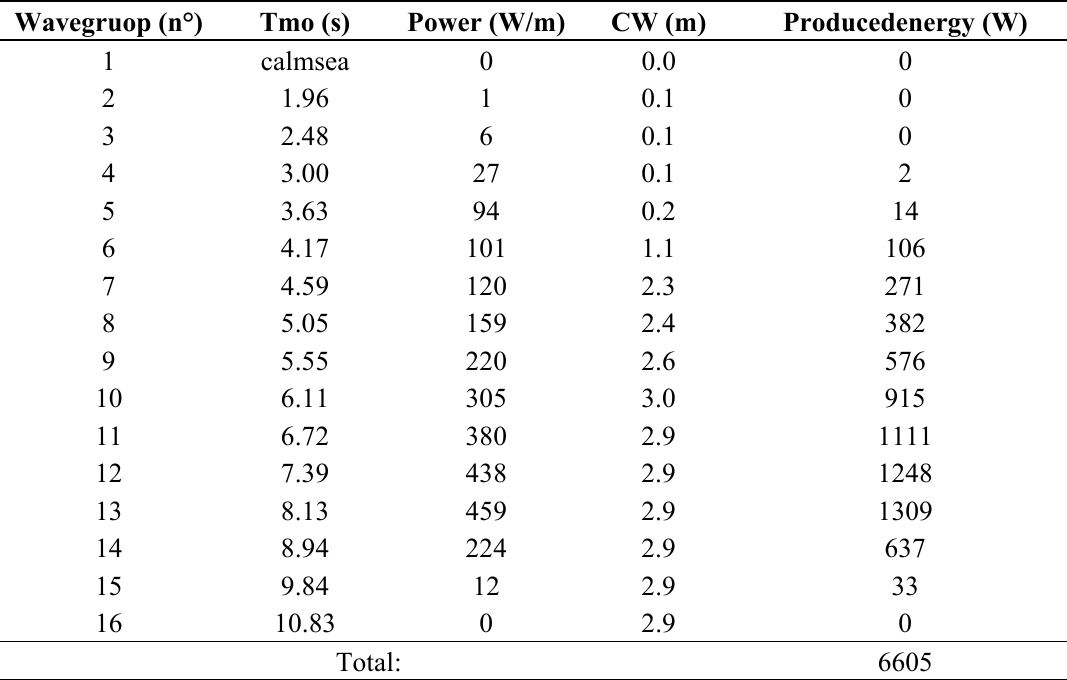
Table 1. Energy produced by a 6 m wide Seabreath, subject to a mild wave climate of 2.5 kW/m. The device efficiency (or capture width) is best for periods close to 6 s. Wavegruop